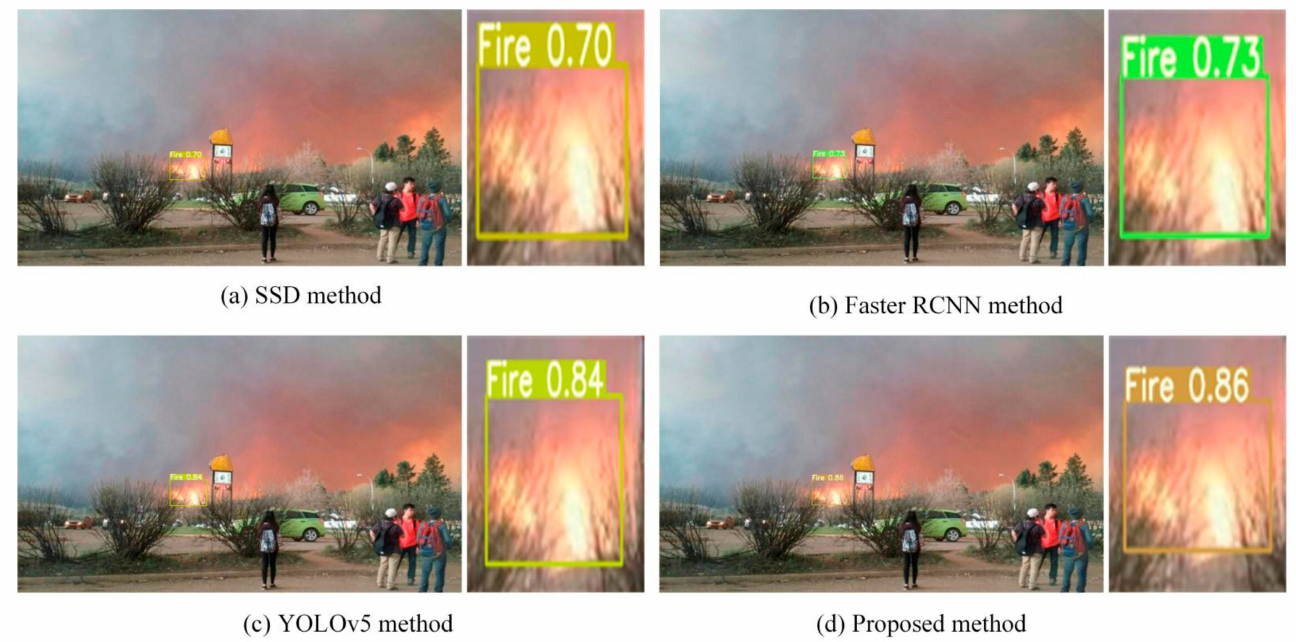
Figure 13. Fire detection of different methods on rainy days.